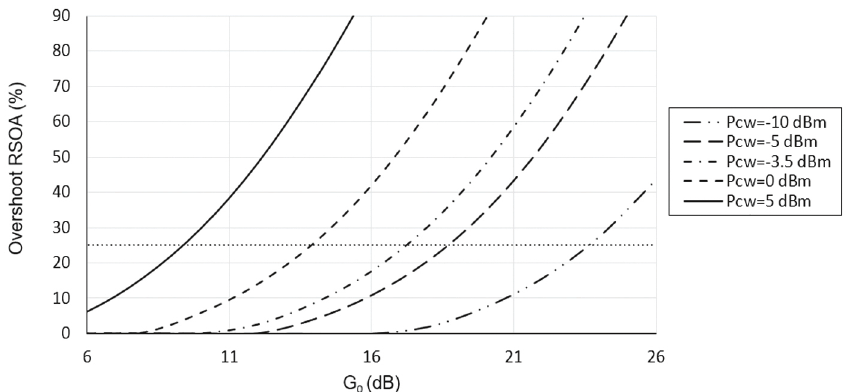
Figure 9. Overshoot at RSOA output vs. RSOA small signal gain for different CW input power. The dotted horizontal line denotes the OVS acceptable limit set at